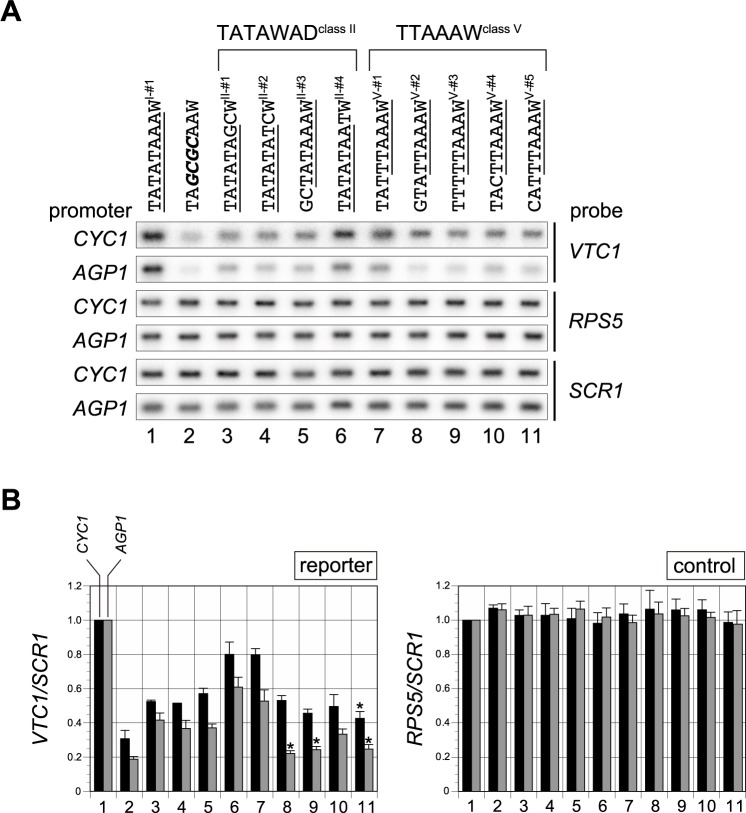
Transcriptional activities of several class II and class V core promoter element (CE) sequences in the CYC1 and AGP1 promoters.A. Northern blot analyses to examine expression of the reporter (VTC1) or control genes (RPS5 and SCR1) in a WT strain carrying a reporter driven by the CYC1 or AGP1 promoter, as indicated on the left, in which the TATA box was replaced with one of several CE sequences of class II (TATAWAD, lanes 3–6) or V (TTAAAW, lanes 7–11), as indicated above the blots. TATATAAA (consensus TATA box, lane 1) or TAGCGCAA (lane 2) sequences were used as positive and negative controls, respectively. The portion of each sequence matching the consensus sequence of each class (i.e., TATAWAWR, TATAWAD, and TTAAAW) is underlined. “W” at the 3’-end of each CE sequence above the blot corresponds to “A” or “T” in the CYC1 or AGP1 promoter, respectively (i.e., the ninth base following the thickly underlined 8 bp sequence in S5 Fig). CYC1 promoter-containing strains were YTK16396, 16398, 16408, 16410, 16412, 16414, 16400, 16402, 16404, 16406, and 16416. AGP1 promoter-containing strains were YTK17952, 17954, 17964, 17966, 17968, 17970, 17956, 17958, 17960, 17962, and 17972 (S1 Table). These strains were grown to logarithmic phase at 25°C in YPD media. Gene-specific probes were indicated on the right. B. Raw data shown in A were quantified and presented graphically. Values for each transcript (left: VTC1; right: RPS5) from strains carrying CYC1 (black bars) or AGP1 (gray bars) promoter-driven reporters were normalized against the level of SCR1 (pol III transcript) and are presented relative to the value for the TATA box (TATATAAAWI-#1, lane 1). Each bar represents the average of biological triplicates, with standard deviation. One representative experiment of three is shown in A. Asterisks in the left panel (lanes 8, 9, and 11) indicate statistically insignificant differences (p > 0.01, one-way ANOVA followed by post-hoc analysis with Tukey's honest significant difference test) relative to the value in the negative control (lane 2).